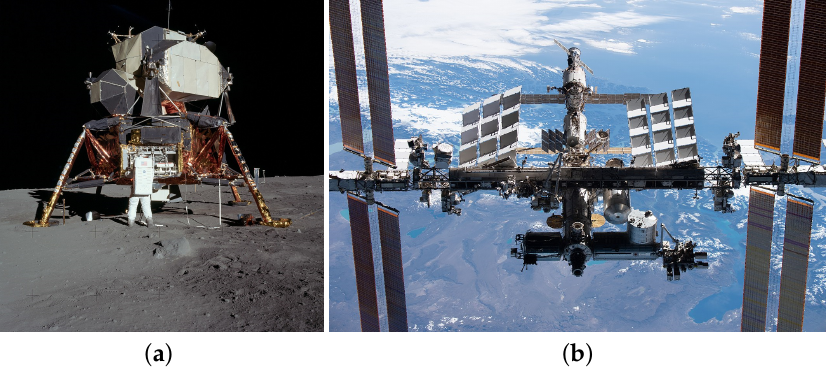
Figure 1. ( a ) Apollo 11 lunar module Eagle and astronaut Buzz Aldrin on the Tranquility Base of the Moon on 20 July 1969 [1]; and ( b ) the view of ISS exterior and steelwork from the departing SpaceX Crew-2 spacecraft on 8 November 2021 [3].